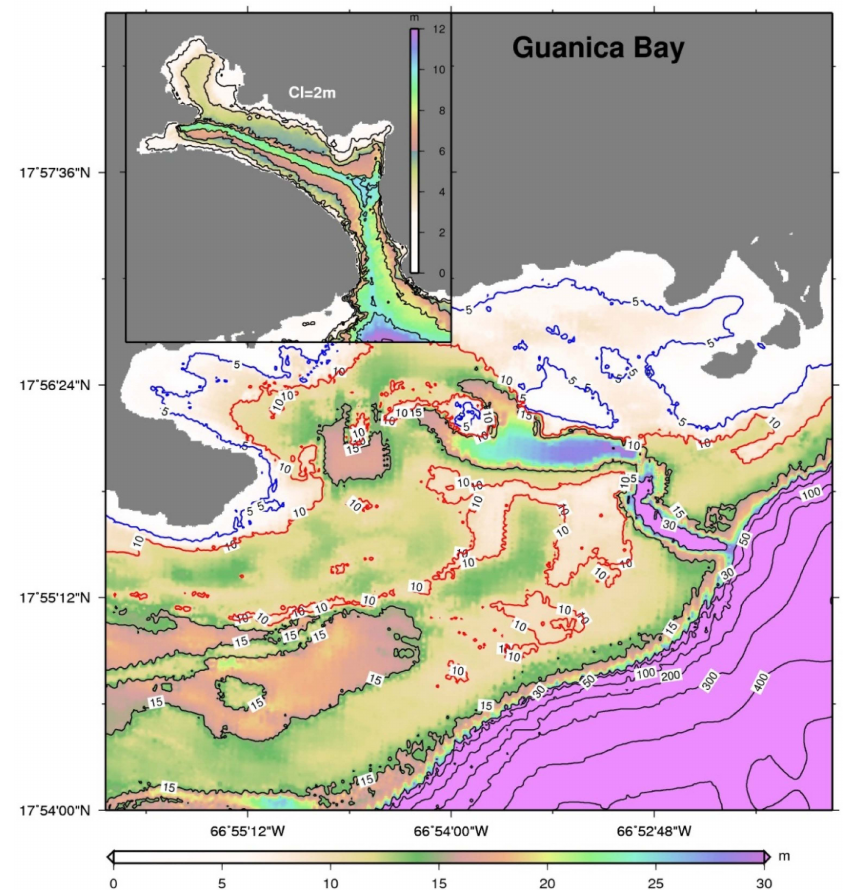
Figure 2. Guánica model domain and bathymetry. Insert marks the shallowest areas and has a different color scale (depths from 0 to 12 m with a 2 m increment). Deeper parts have the following depth contour lines: 5 m, 10 m, 15 m, 30 m, 50 m, 100 m, 200 m, 300 m and 400 m; 5 m contours are marked in blue and 10 m contours are marked in red to showcase reef areas. Deeper oceanic parts are marked with magenta color and have contours every 100m. Note the deeper channel within the long and narrow channel connecting the shallow embayment at the head of the Guánica Bay (where river runoff is introduced) with the offshore reefs. This channel was artificially dredged for shipping. As